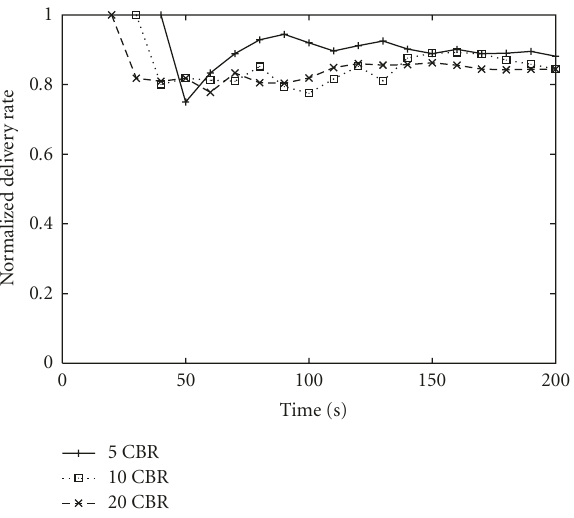
Figure 18: The influence of tra ffi c in AODV performance when ap- plied the delete and replace